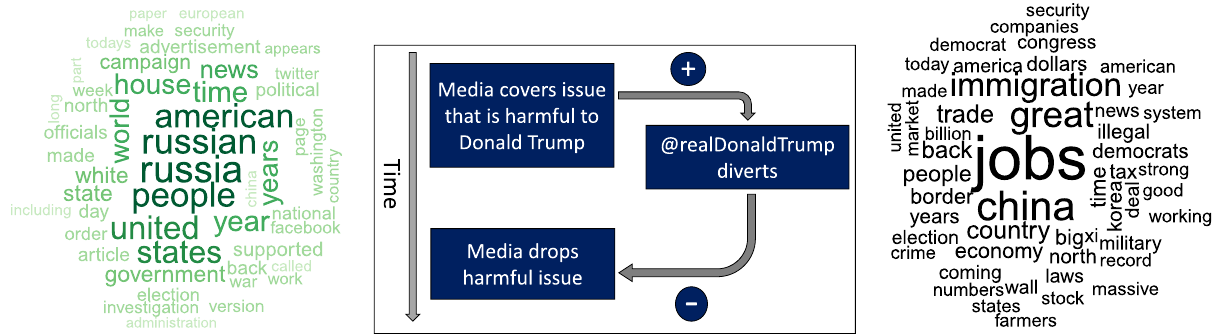
Fig. 1 The center panel shows a conceptual model of potential strategic diversion by Donald Trump via Twitter (where his handle is @realDonaldTrump). The word cloud on the left contains the 50 most frequent words from all articles in the NYT that contained “ Russia ” or “ Mueller ” as keywords. The NYT articles captured by the word cloud contained a total of 146,307 unique words. We excluded “ president ” and “ Trump ” because of their outlying high frequency. In addition to the 50 words shown here, the top 1% of high-frequency items included terms such as “ collusion, ” “ impeachment, ” “ conspiracy, ” and numerous names of actors relevant to the investigation, such as “ Mueller, ” “ Putin, ” “ Comey, ” “ Manafort, ” and so on. The word cloud on the right represents the 50 most frequent words occurring in Donald Trump ’ s tweets that were chosen, on the basis of keywords, to represent his preferred topics. The expected sign of the regression coef fi cient is shown next to each path and is identical for both approaches (OLS and 3SLS). The delay between media coverage and diversionary tweets is assumed to be shorter than the subsequent response of the media to the diversion. This re fl ects the relative sluggishness of the news cycle compared to Donald Trump ’ s instant-response capability on